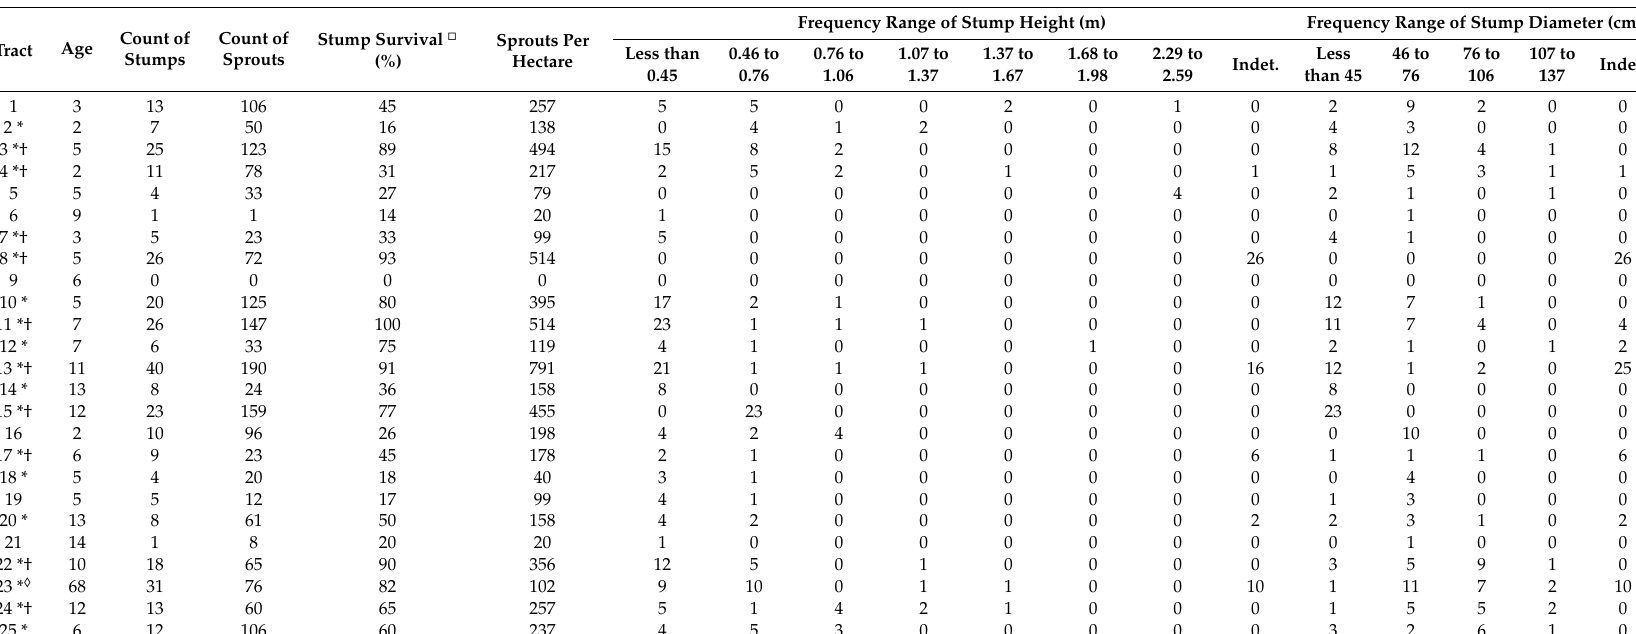
Table 7. Count of stumps and stump sprouts, percent of surviving stumps, and height and diameter of live cypress ( Taxodium distichum ), tupelo ( Nyssa species), and all other desirable species listed in Table 2 by each of the 25 tracts